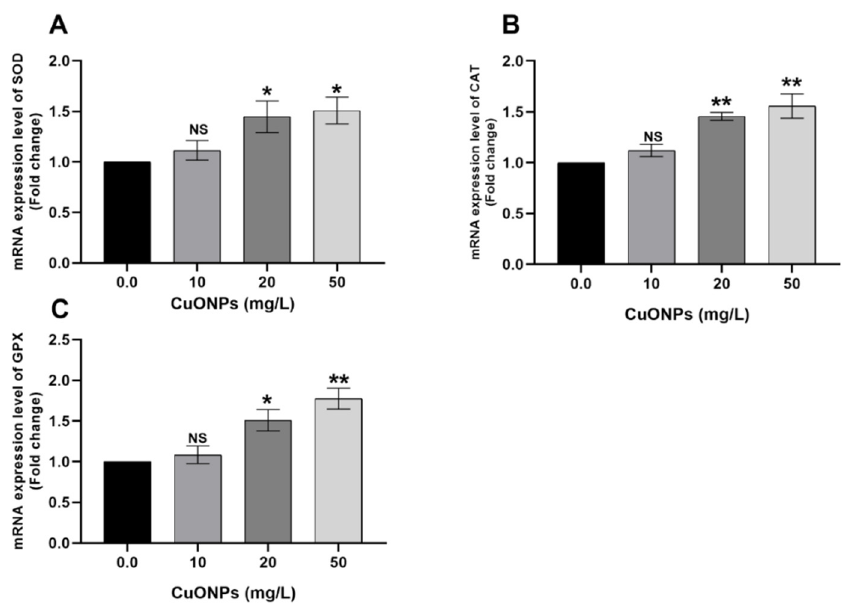
Figure 2. mRNA transcription profile of oxidative stress-related genes including SOD ( A ), CAT ( B ), and GPX ( C ) in the gills of Nile tilapia juveniles after exposure to sub-lethal concentrations of CuONPs (0.0, 10, 20, and 50 mg/L) for 25 days. The values are expressed as mean ± SEM ( n = 9). Asterisk (*) ( p < 0.05) and (**) ( p < 0.01) indicate significant differences between the exposure groups compared with the control group. NS indicates non-significant differences.